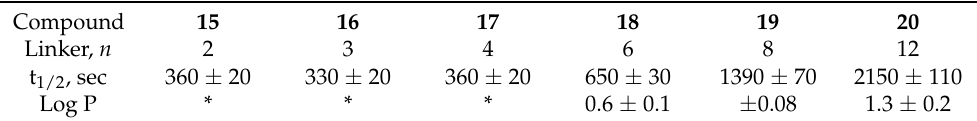
Table 1. Half-transformation times and log P values for Ru(III)